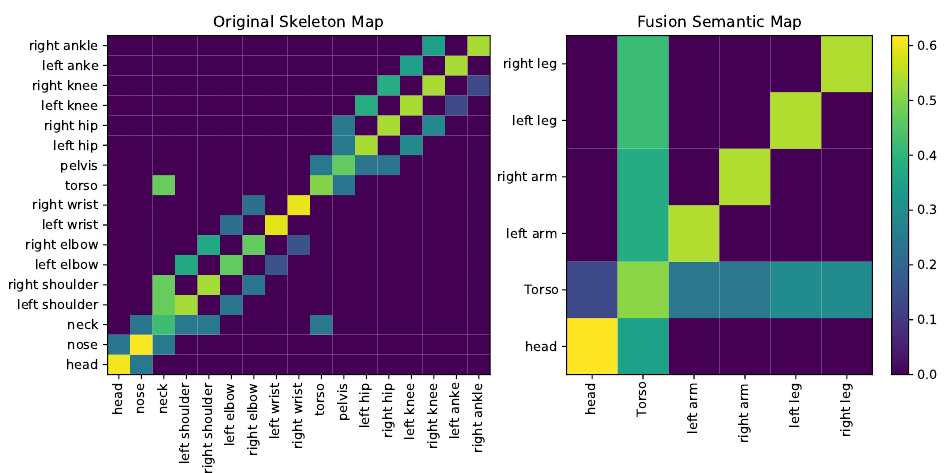
Figure 5. Visualization of learned weighting matrices, M , of S-GCN in the network. Comparison with the state of the art. Tables 1 and 2 show the results of comparing our proposed STUNet model with other baselines on Human3.6M. We show the performance of our 27-frame, 81-frame, and 243-frame models to compare the performance differences of our models under different perceptual domains. Among them, the bold result is the best. The experiments show that our 243-frame model achieved the best mean error values under protocols 1 and 2. Specifically, we had six tasks reach the optimum under